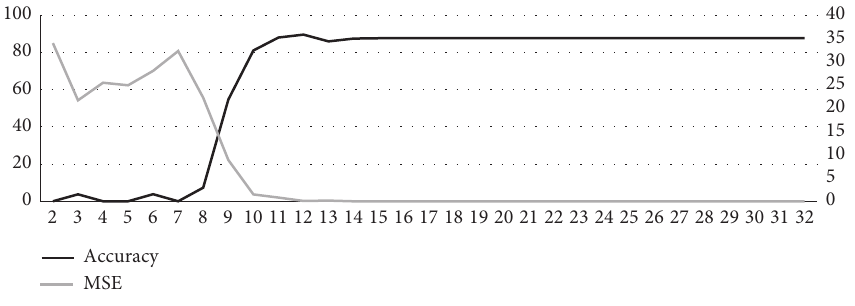
Figure 5: Accuracy and MSE to the change of the number of bits of filter elements. Table 2: Results of the first quantization analysis.